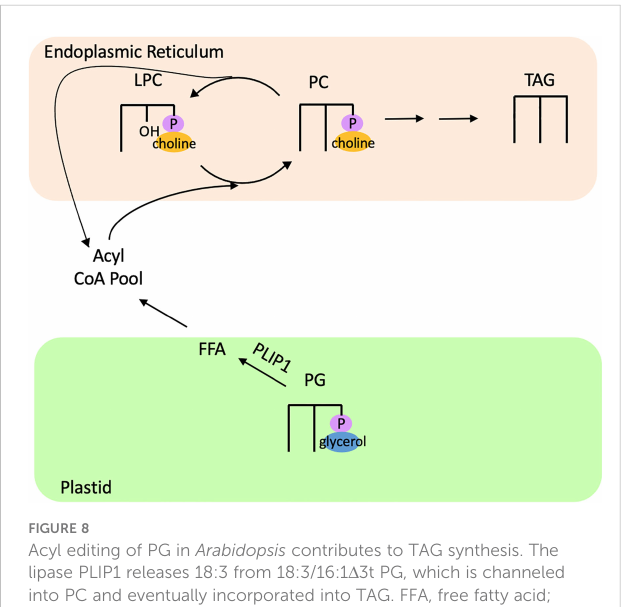
FIGURE 8 Acyl editing of PG in Arabidopsis contributes to TAG synthesis. The lipase PLIP1 releases 18:3 from 18:3/16:1 D 3t PG, which is channeled into PC and eventually incorporated into TAG. FFA, free fatty acid; LPC, lysophosphatidylcholine; PC, phosphatidylcholine; PG, phosphatidylglycerol; PLIP1, Plastid Lipase 1; TAG,